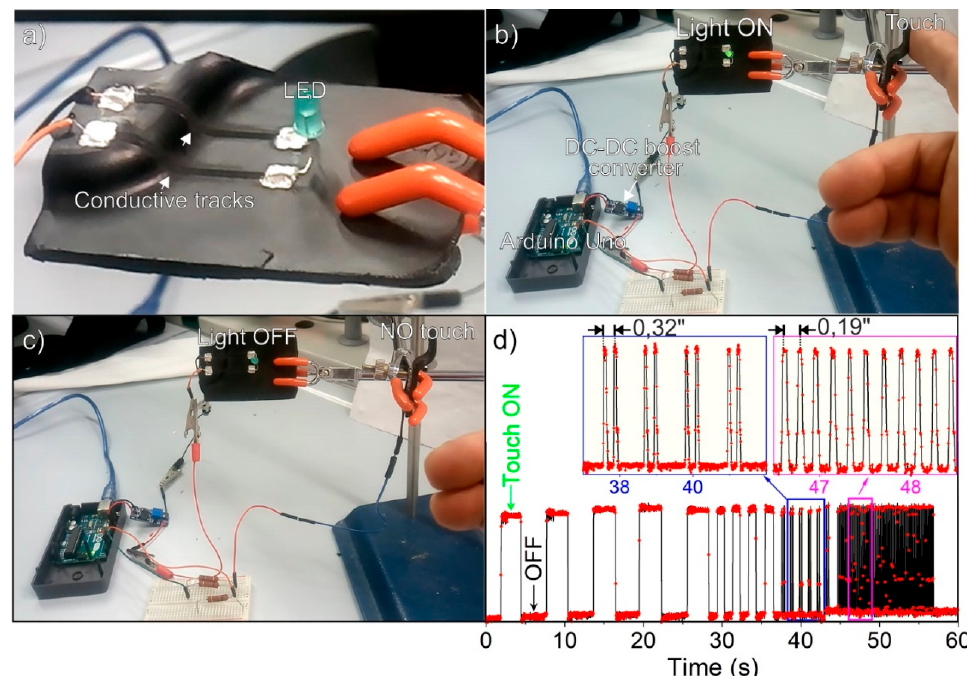
Figure 10. Proof of concept of the capacitive sensor connected with a LED and with conductive tracks: ( a ) two 50 mm long laser-stimulated conductive tracks connected with a light-emitting diode (LED), ( b ) brightness with the finger touching, ( c ) no brightness without touching, ( d ) time responsivity under ON/OFF touching cycles. Single and dual-touch tests are illustrated in the insets of ( d ).